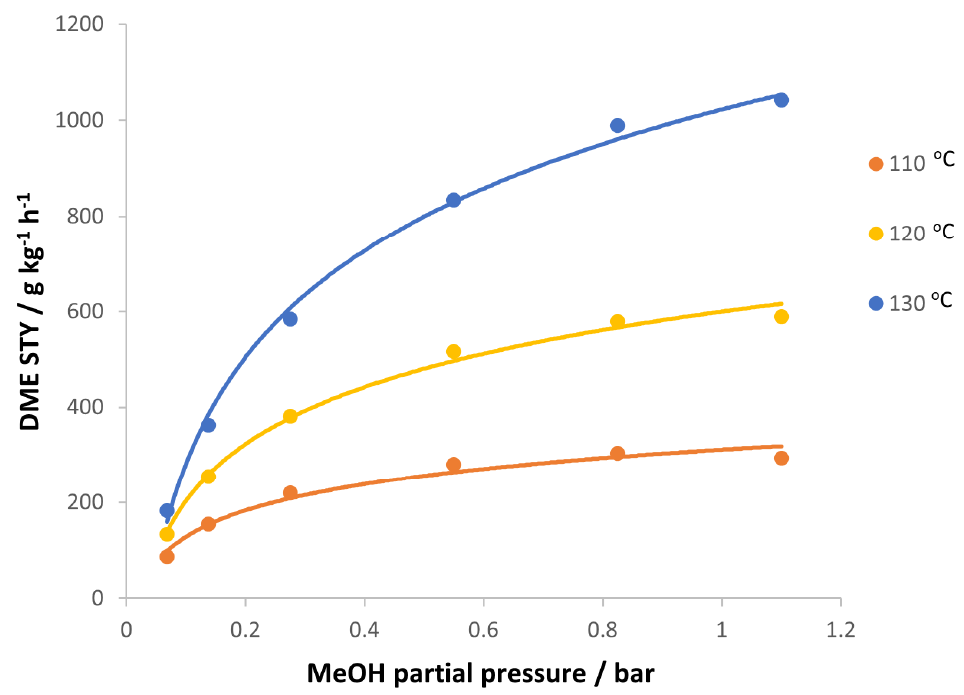
Figure 4. DME STY of the H-ZSM-5 SAR80 catalyst versus the methanol partial pressure cofed with 0.11 bar methyl n -hexanoate at different reaction temperatures: 110, 120 and 130 °C. The curves are guides for the eye only.